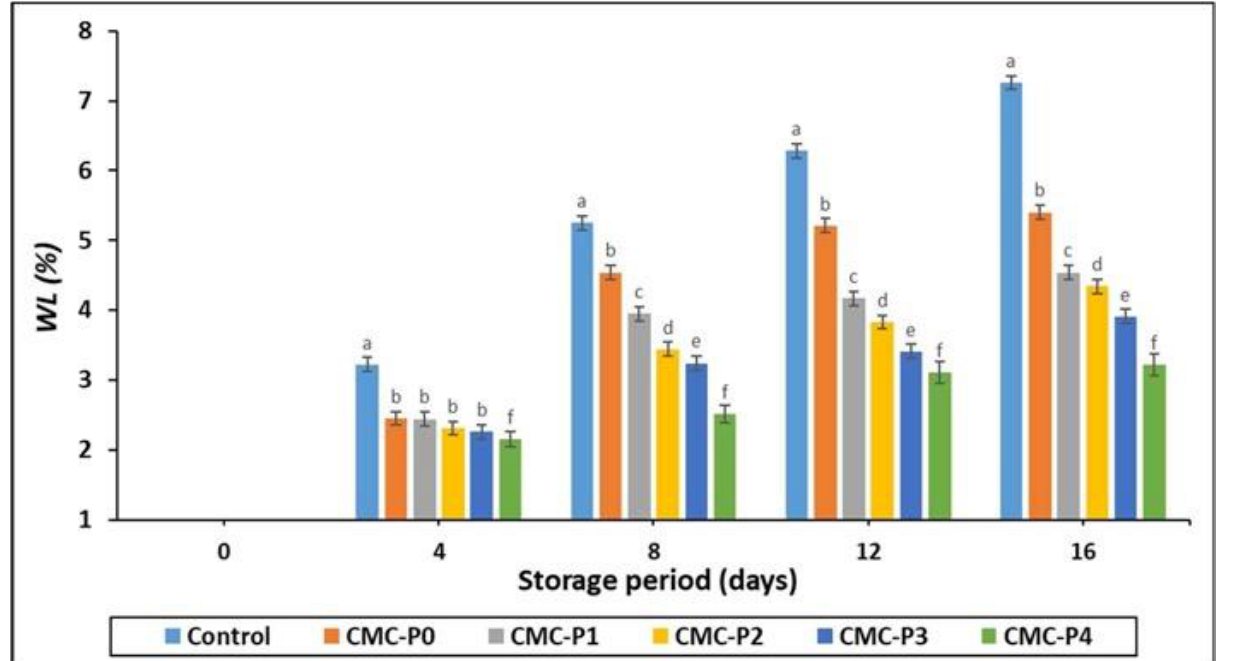
Figure 2. The impact of applied coatings on the WL (%) of chicken breast meat samples during storage at 2 °C for 16 days. Control : Uncoated chicken breast meat samples (soaked samples in sterile distilled water). CMC-P0 : CMC-coated chicken breast meat samples with 0% EPE. CMC-P1 : CMC-coated chicken breast meat samples with 1% EPE. CMC-P2 : CMC-coated chicken breast meat samples with 2% EPE. CMC-P3 : CMC-coated chicken breast meat samples with 3% EPE. CMC-P4 : CMC-coated chicken breast meat samples with 4% EPE. a – f : Within a column, different superscripts indicate significant differences ( p ≤ 0.05 ).